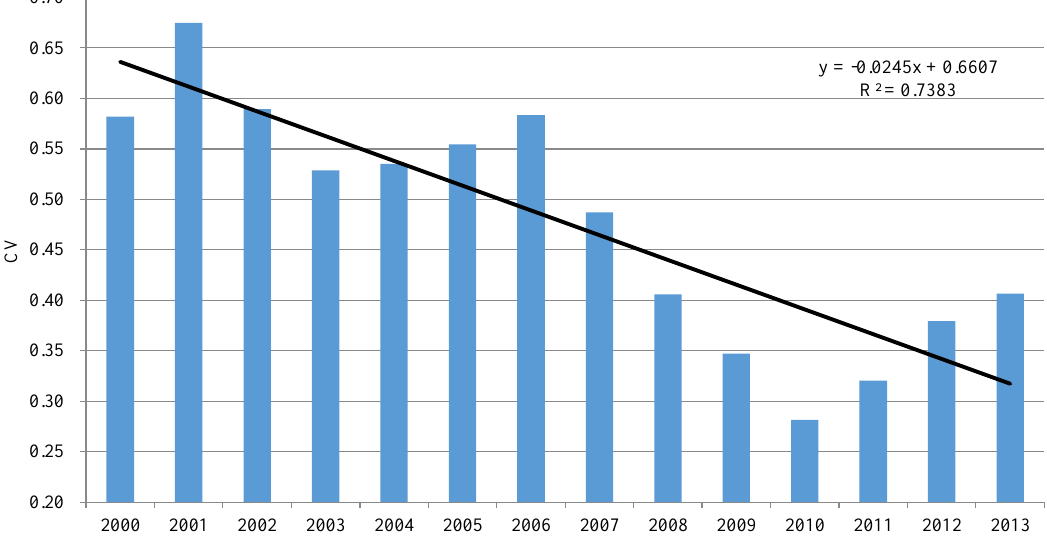
Figure 10. Variation in environmental efficiency across the 30 provincial power grids, 2000–2013. Note: CV stands for coefficient of variation.